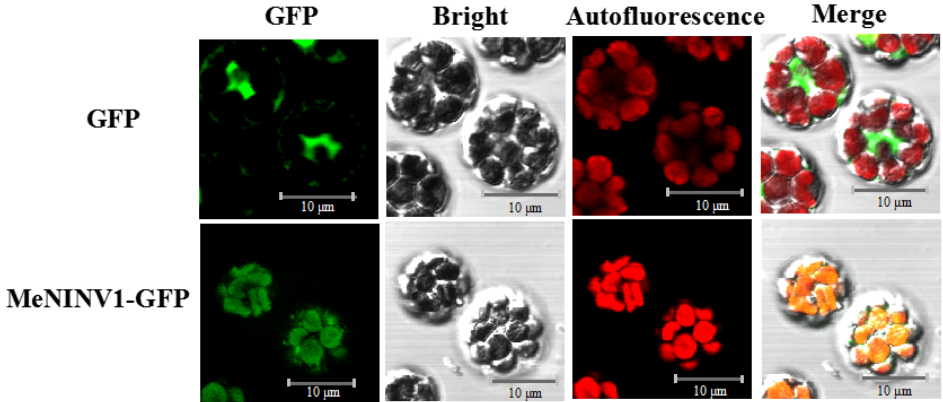
Figure 3. Subcellular localization of MeNINV1 in cassava mesophyll protoplasts. GFP fluorescence was observed using the green channel, and chlorophyll autofluorescence was visualized using the red channel. Bar = 10 μ m.